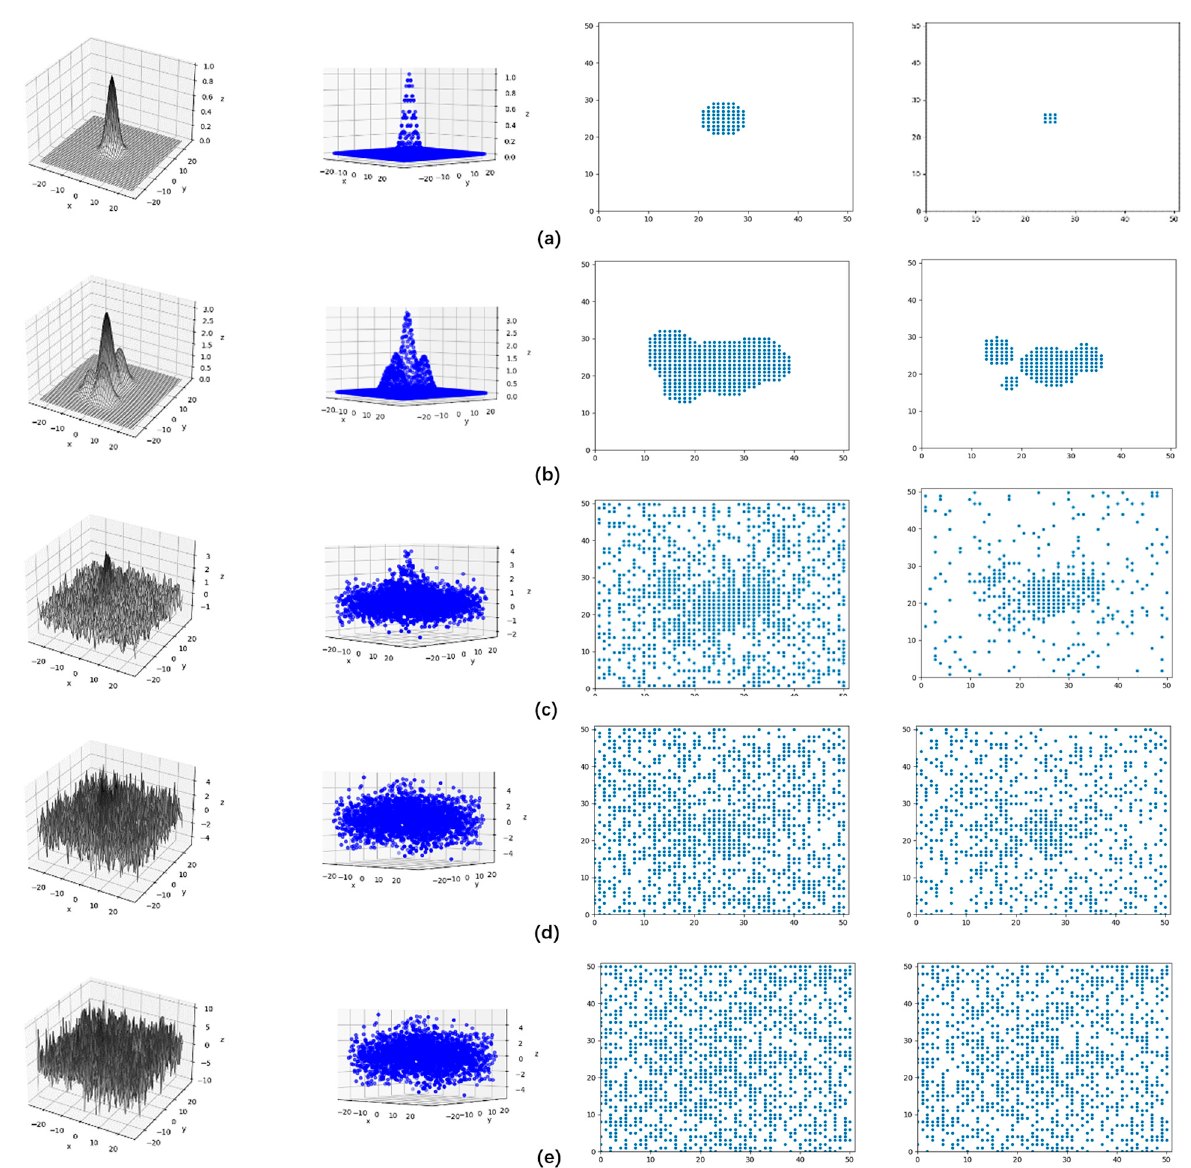
Figure 5. Diagram of preprocessing under different conditions: ( a ) is the ideal imaging of a point target; ( b ) is the imaging of a point target after multi-frame superimposition; ( c ) has superimposed noise compared with ( b ); ( d ) has reduced SNR; ( e ) is pure noise.